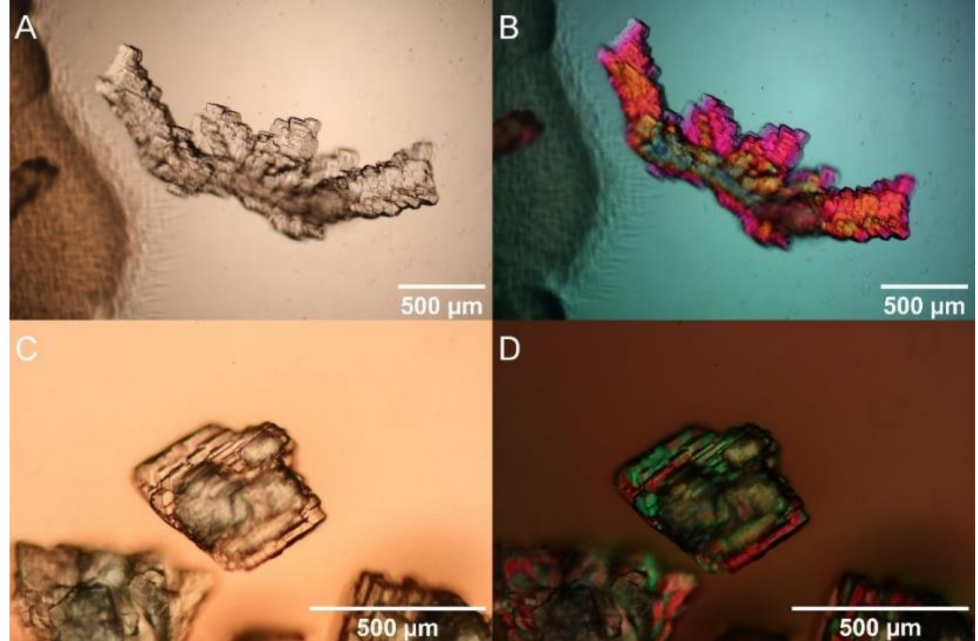
Figure 2. Polarized microscopy of crystals produced by S. mirabilis . Crystals produced by the wildtype in TSA ( A , B ) or TSA + 10 mM NiSO 4 (C, D) were compared by light microscopy ( A , C ) and under polarized light ( B , D